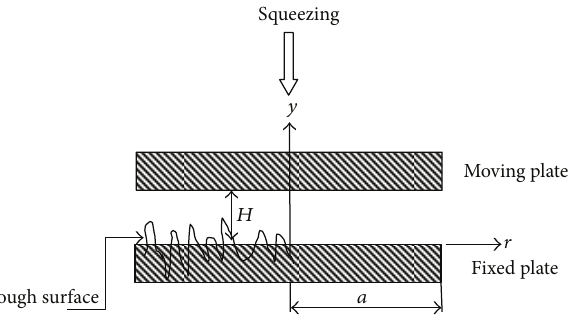
Figure 1: Geometry of parallel circular